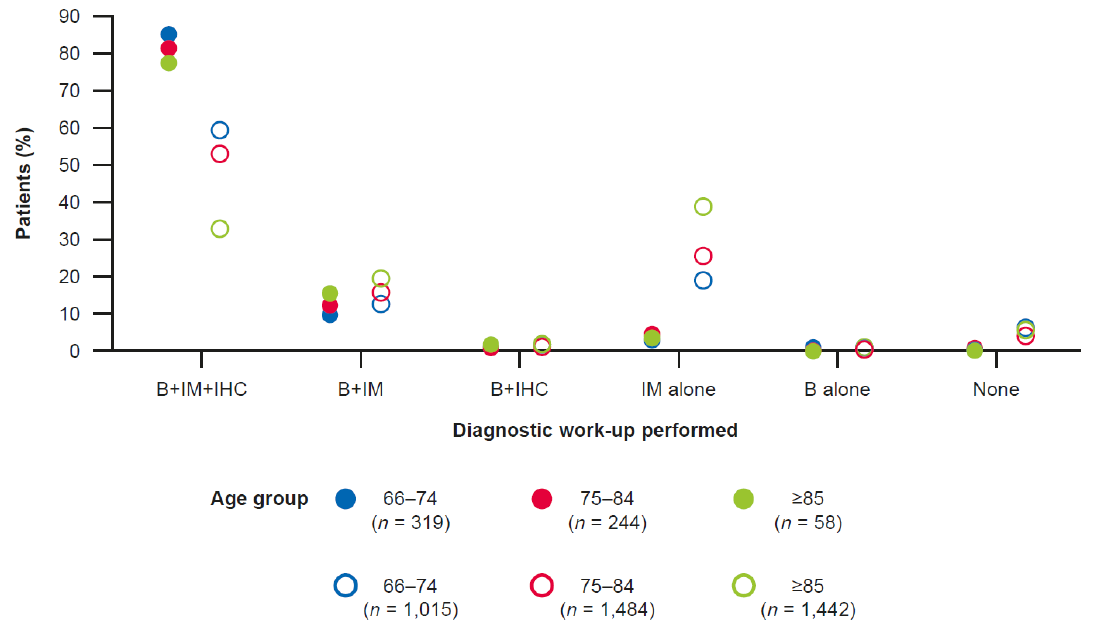
Figure 1. Trends in the number of diagnostics a performed among treated ( n = 621; closed circles) and untreated patients ( n = 3,941; open circles) with CUP. B, biopsy; CUP, cancer-of-unknown-primary-origin; IHC, immunohistochemistry; IM, imaging. a Record of claim for a biopsy, immunohistochemistry, or imaging modality (computed tomography, positron emission tomography, magnetic resonance imaging) for any reason.